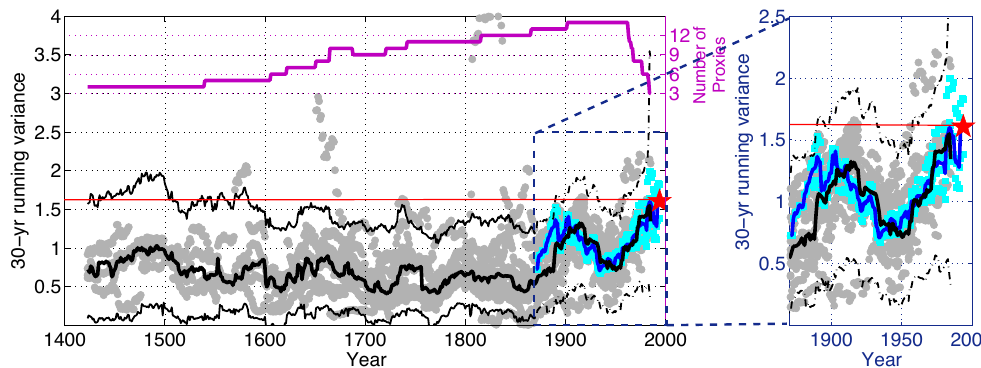
Figure 7: The running variance (grey dots) of each of the 14 ENSO reconstructions, overlaid with the MRV (thick black line). At any point in time prior to the observation period, the thin black lines represent the widest median running variance signal error bars of the two types of error analysis detailed in Appendix A. Inside the window of instrumental data these error bars change to thin black dash-dot lines, as we have a direct measurement of ENSO variance. The width of each of these two error bar estimates varies depending on the number of ENSO variance proxies available (see purple line at top of panel). Cyan dots indicate the running variance of 4 different estimates of observed ENSO (Table 2), while the blue line represents the MRV of these observed ENSO running variance time series. The red star indicates the most recent value of the observed MRV, while the thin red line just extends this most recent value back through time, for comparison with the ENSO reconstruction MRV and its error bars.